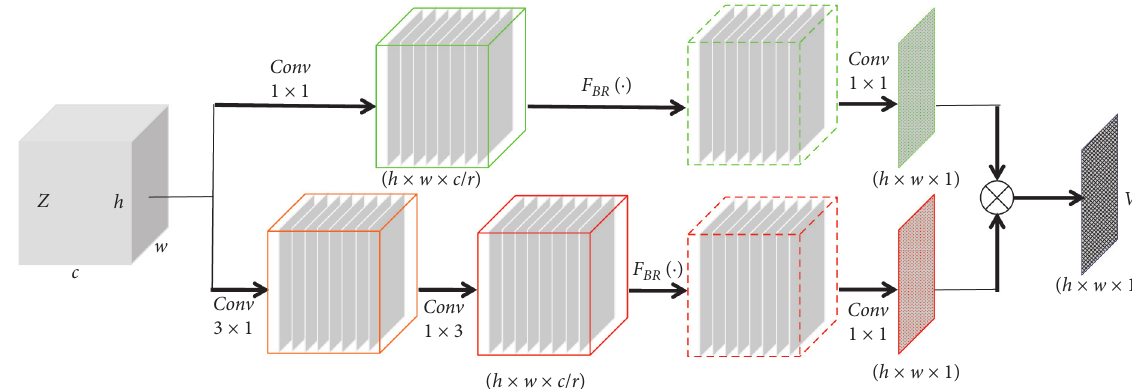
Figure 5: Proposed spatial attention branch